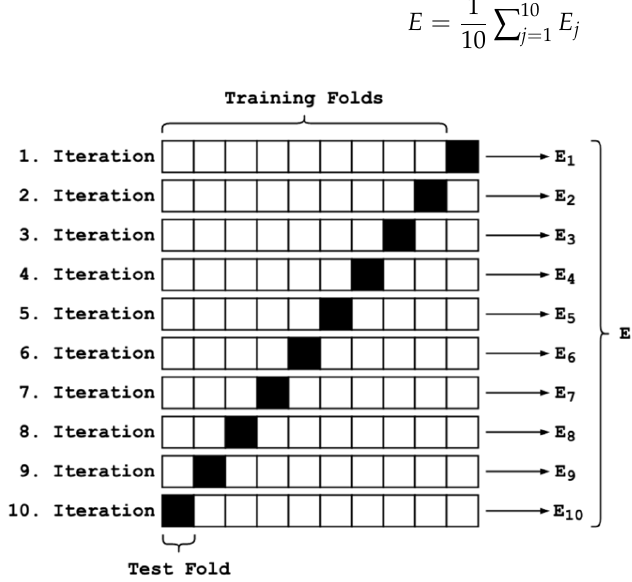
Figure 3. Cross-validation with 10 folds.